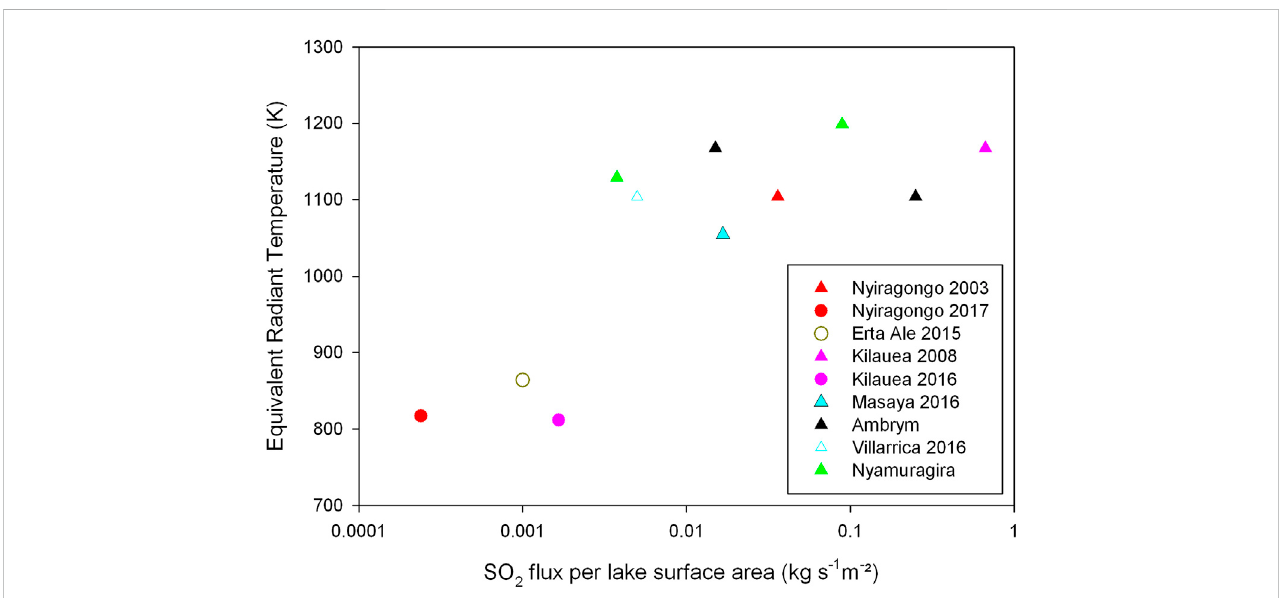
FIGURE 9 Diagramoftheapparentradianttemperature versus SO 2 fl uxperareaforthedataofTable1.Theuppergroupcorrespondstochaotic(hot,gas-richlakes) while the lower group corresponds to ordered (colder, gas-poor